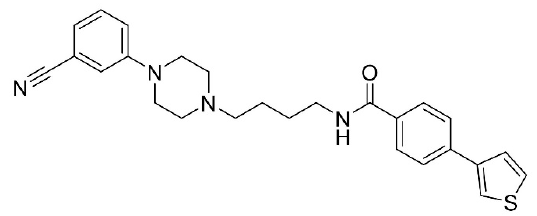
Figure 1. Structure of MC-25-41.